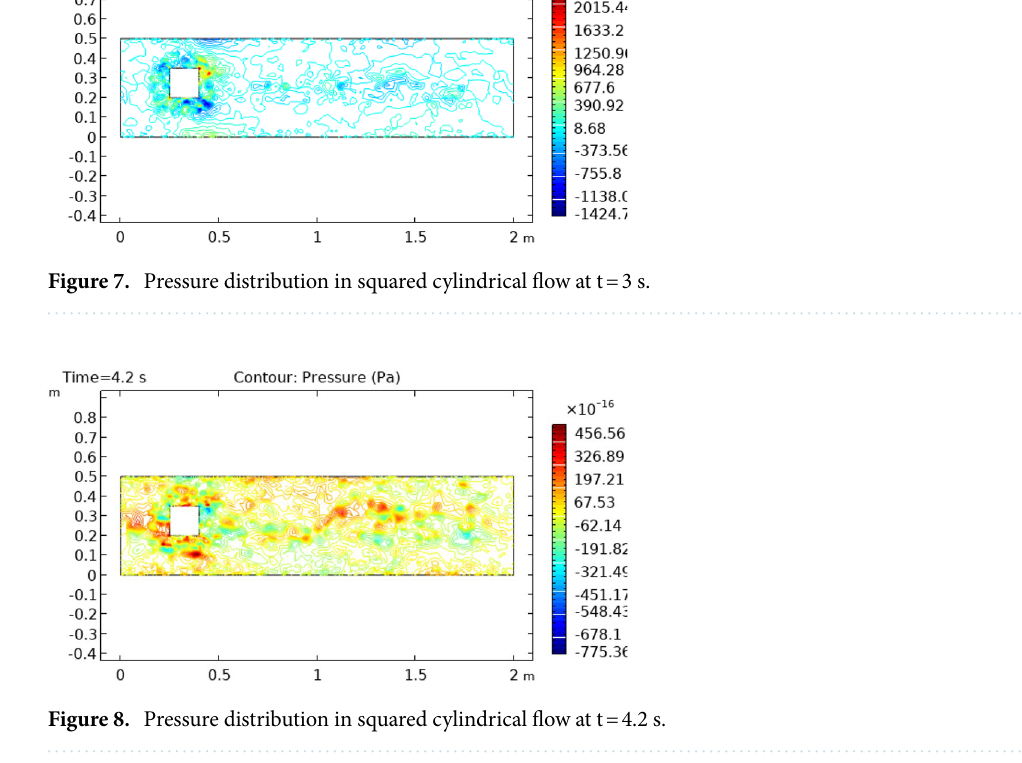
and 1106.7 × 10 − 16 m / s for a time interval of 5.4 s. Figure 10 and 11 show the surface temperature around the squared figure block kept in the flow of fluid at time intervals t = 0.2 s and t = 3 s, respectively. Boundary layers of the fluid show the maximum value of temperature throughout the flow which is 360 K in Fig. 10 and 370 K in Fig. 11. The middle layers of flow show minimum values of temperature which is 232 K in Fig. 10 and 280 K in Fig. 11. The other remaining layers oscillate between these maximum and minimum values.